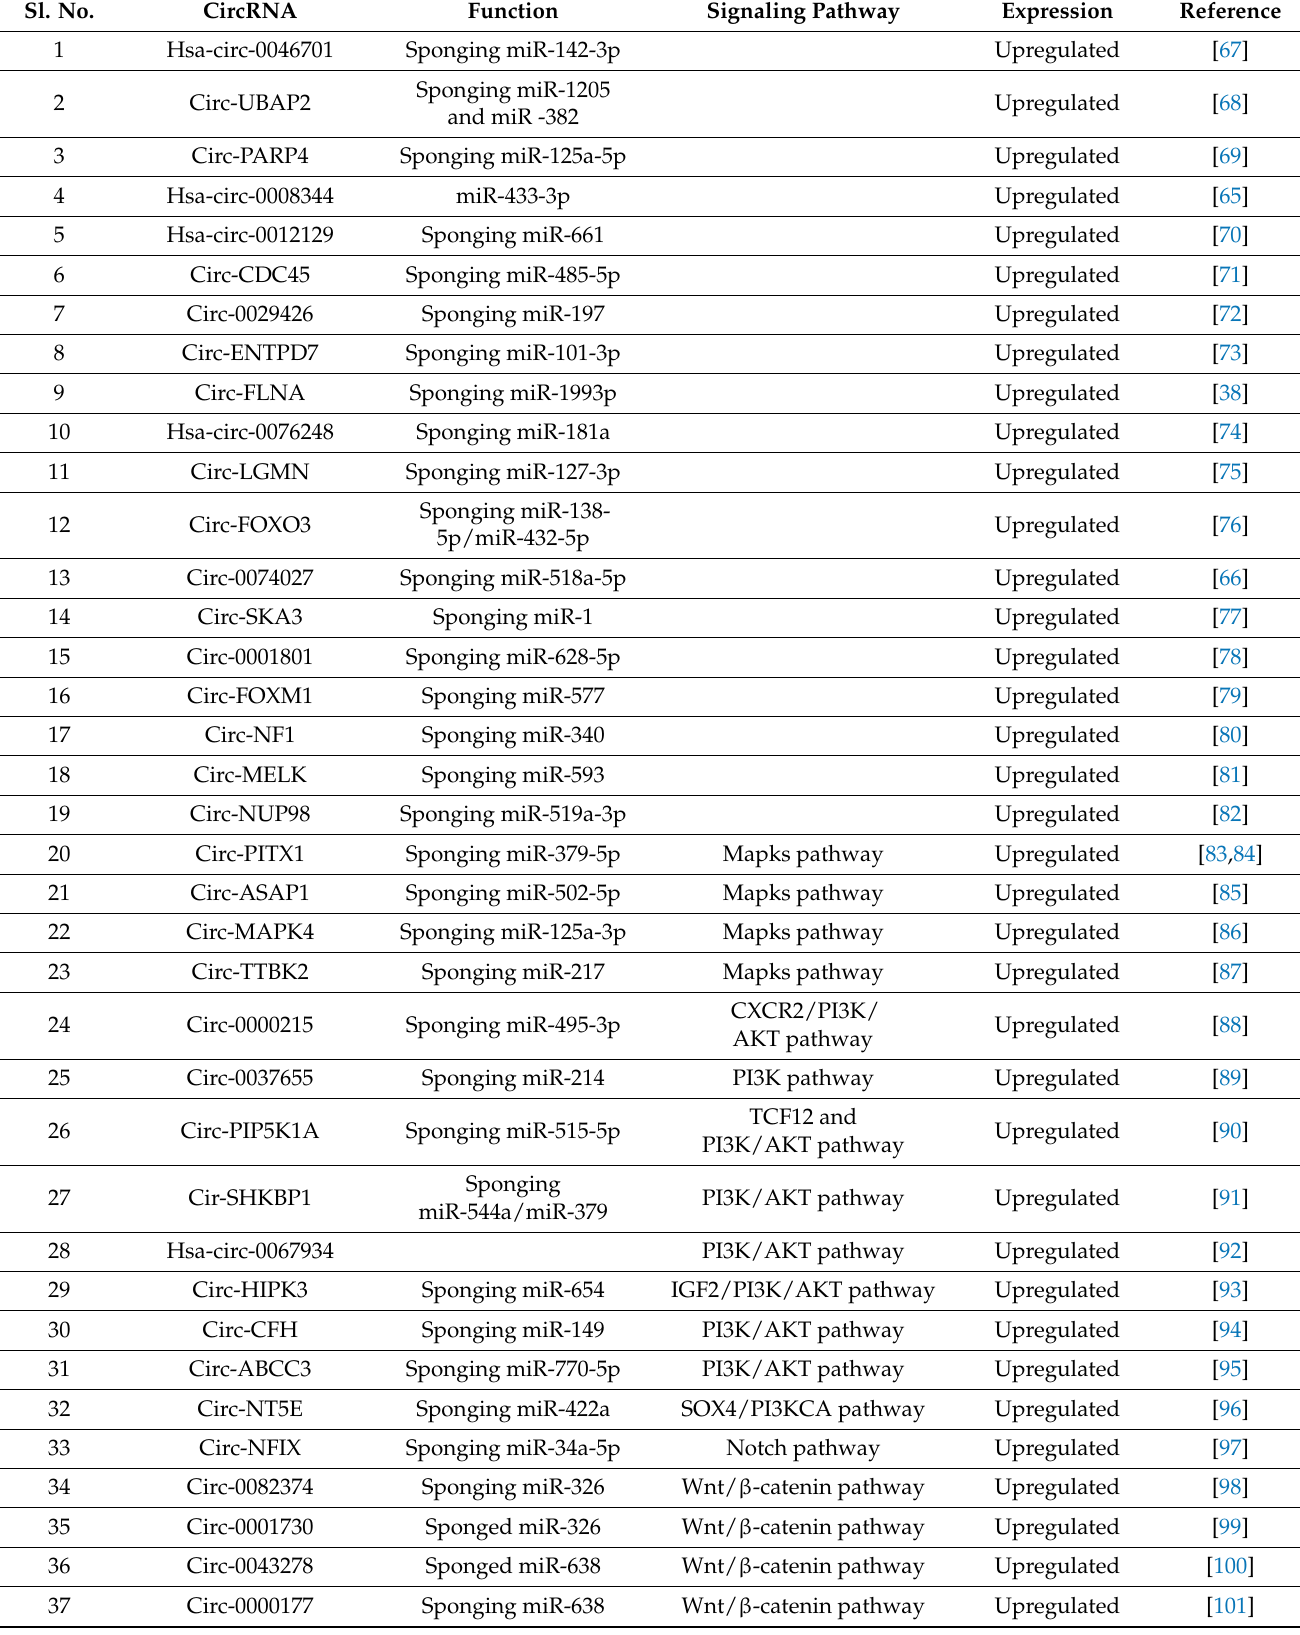
Table 2. List of circRNAs responsible for the up-regulation of glioblastoma. Sl.